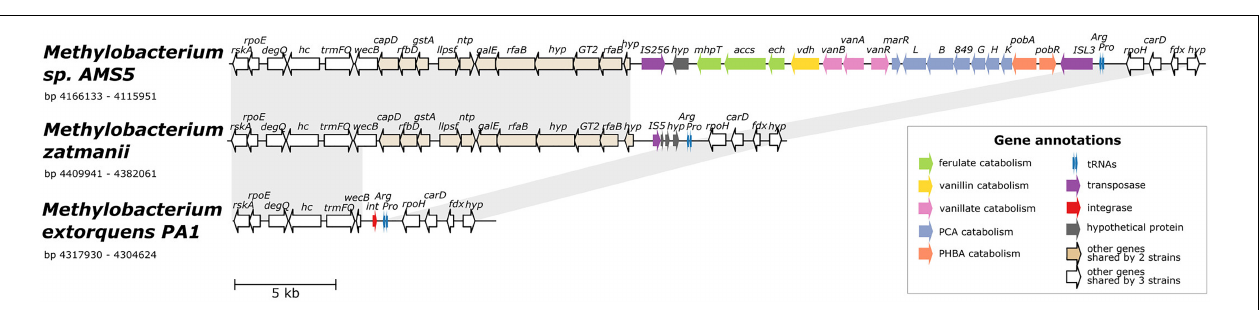
FIGURE 4 | Alignment of three genomes from the extorquens clade reveals that Methylobacterium sp. AMS-5 harbors a catabolic island conferring the ability to degrade several aromatic substrates, in a genomic region prone to insertions and deletions. The genome of Methylobacterium sp. AMS5 is shown aligned with that of two close relatives, M. zatmanii PSBB041 and M. extorquens PA1. Genes are color-coded to indicate either function or commonality between genomes, as indicated by the key. Light gray shading between pairs of species connects regions shared by both. See Supplementary Table 3 for full annotations corresponding to the short gene